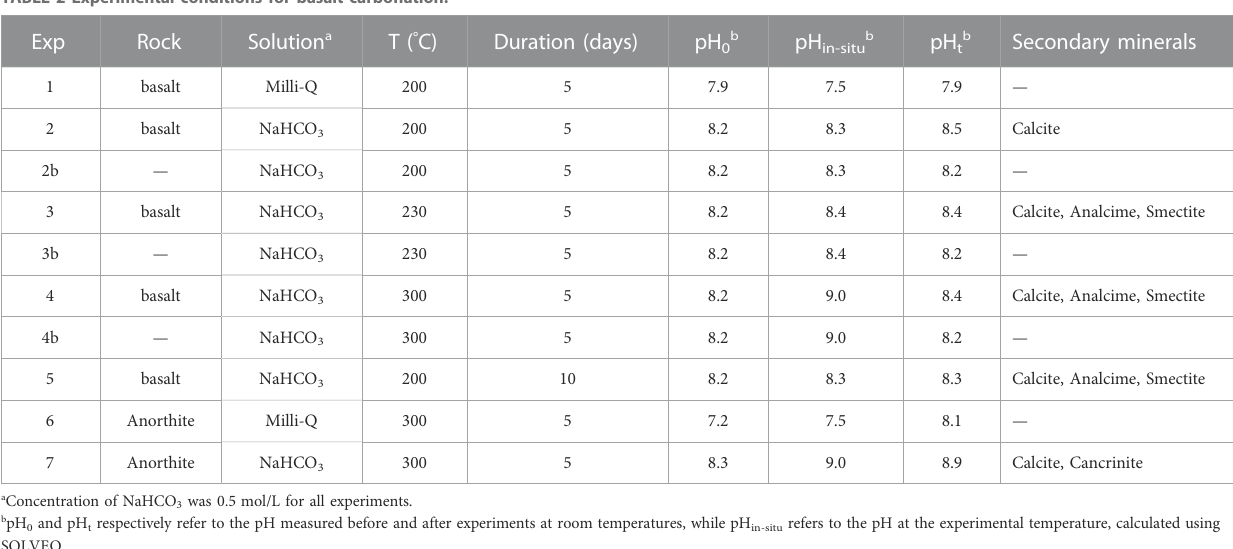
TABLE 2 Experimental conditions for basalt carbonation.